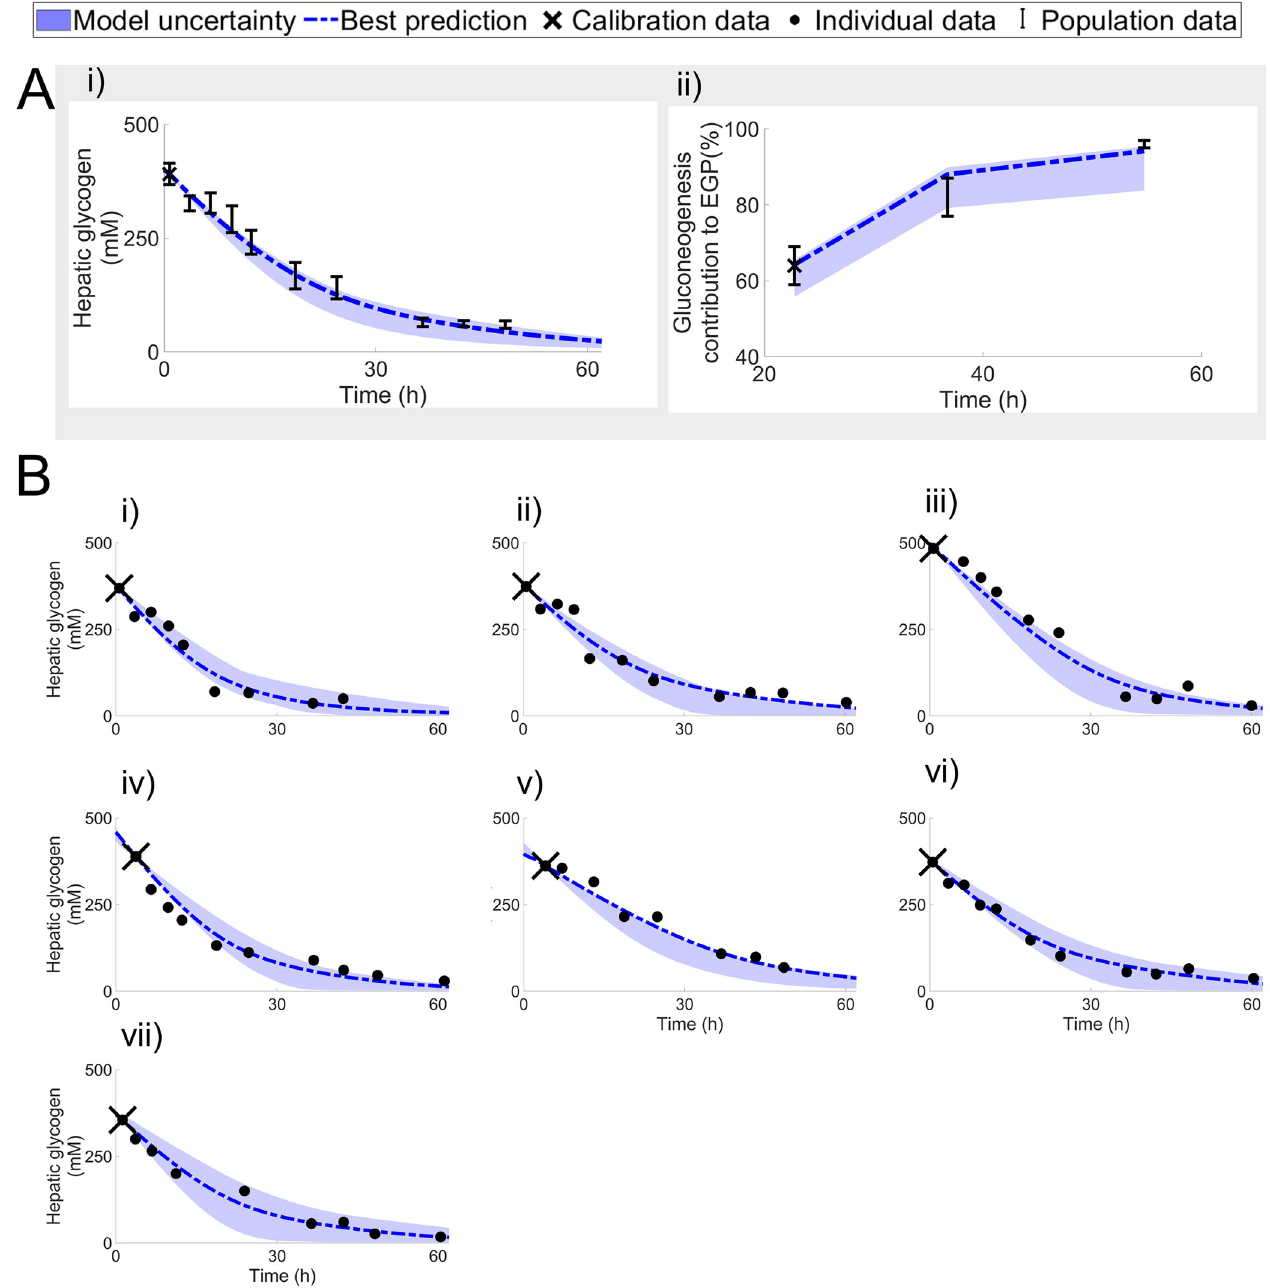
Fig 4. The first validation test done with the model, using the Rothman data [29]. In all plots, data values are depicted with a dot, SEM uncertainty by the error bar, simulation uncertainties are depicted by the areas, and a simulation using the model parameters that best agree with the data is depicted with the line. The first data point (also depicted with an X) is used for personalising the model, and the rest are used for validation. The study monitors the response of hepatic glycogen, and of the contribution of glycogenolysis to EGP, during a 68 h fast. (A) Prediction of hepatic glycogen levels and gluconeogenesis contribution to the endogenous glucose production on the full population. (B) Prediction of hepatic glycogen levels on an individual level.